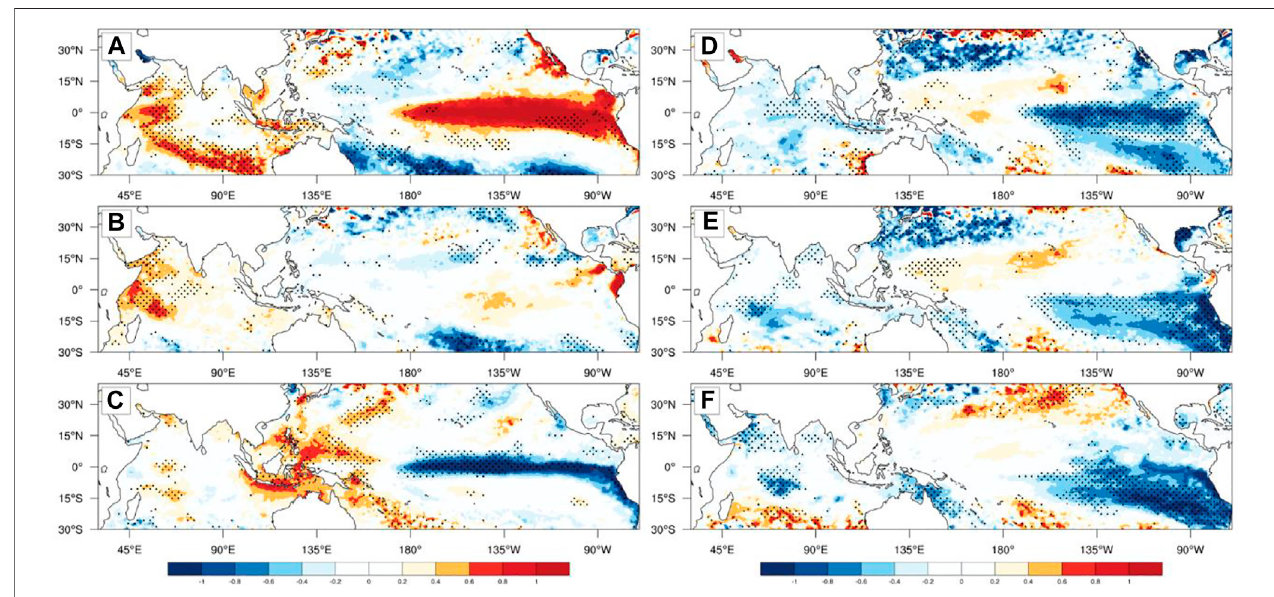
FIGURE 5 | Differences in SSTA (unit: K) between the composites of positive and negative years [ (A,D) for pre-winter (DJF), (B,E) for spring (MAM) and (C,F) for summer (JAS); (A – C) for P1 and (D – F) for P2; dotted areas indicate the values are signi fi cant at/above the 95% con fi dence level by Student ’ s t test].